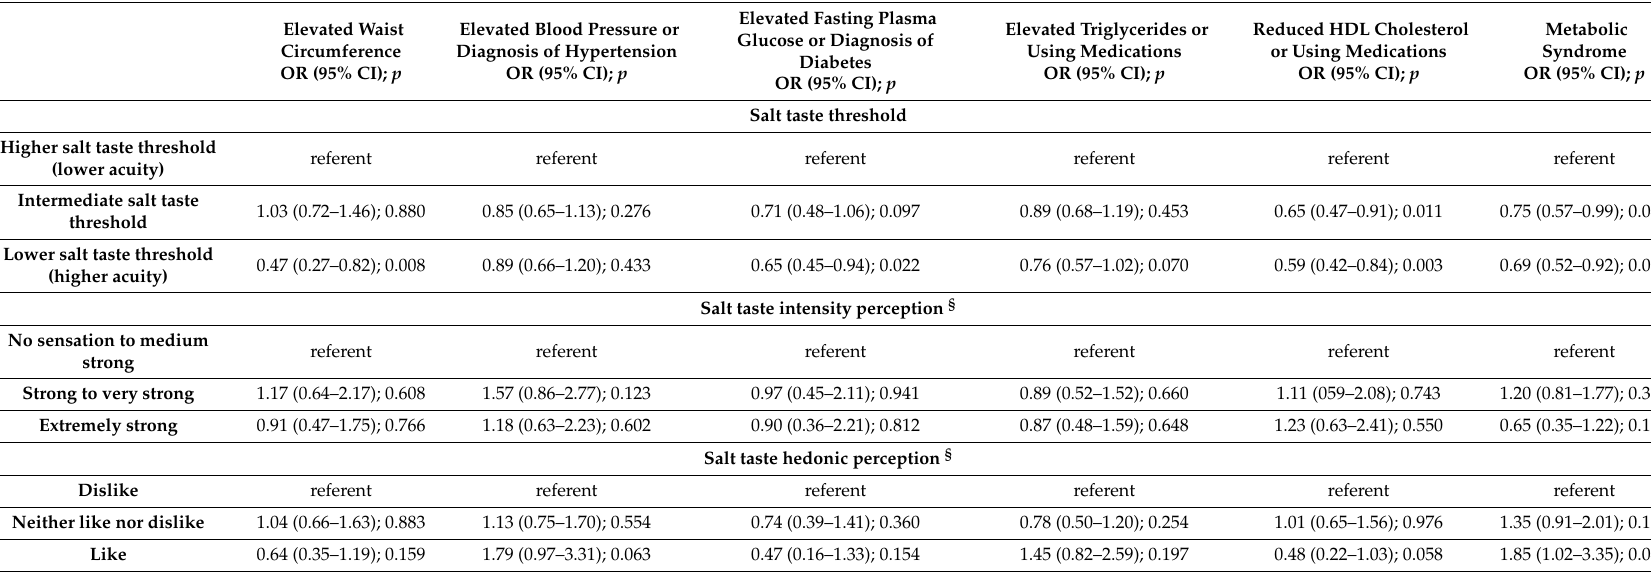
Table 5. Association between metabolic syndrome and its components and salt taste threshold and suprathreshold perception. Elevated Waist